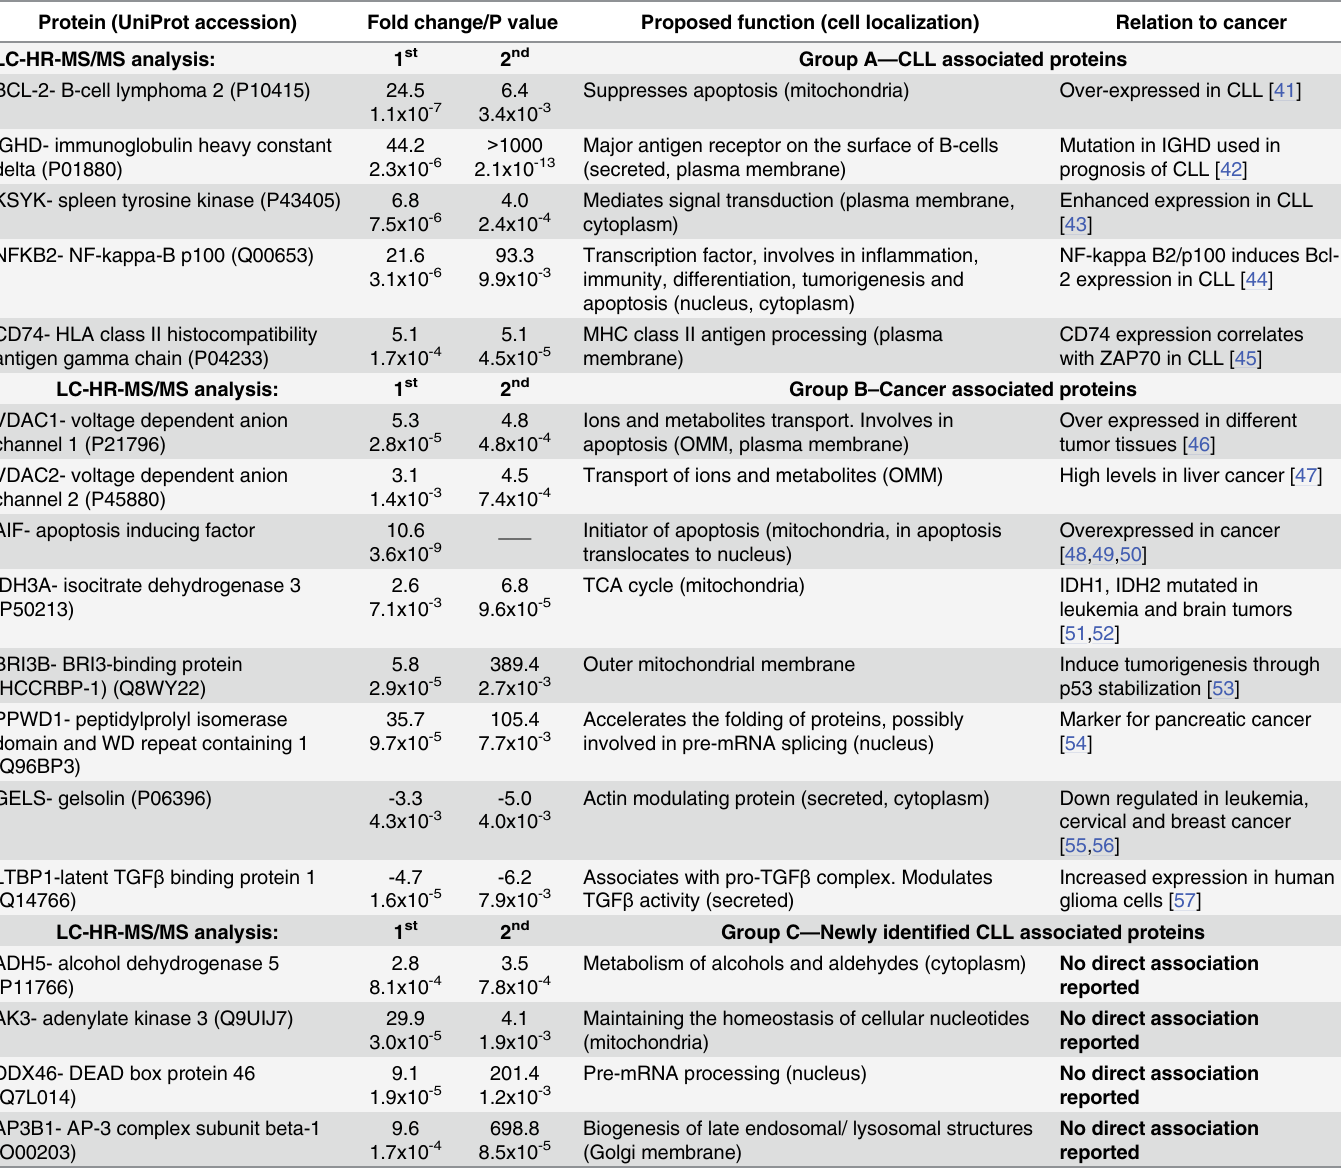
Table 1. List of selected proteins differentially expressed between healthy donors and CLL patients identified by LC-HR-MS/MS. Protein (UniProt